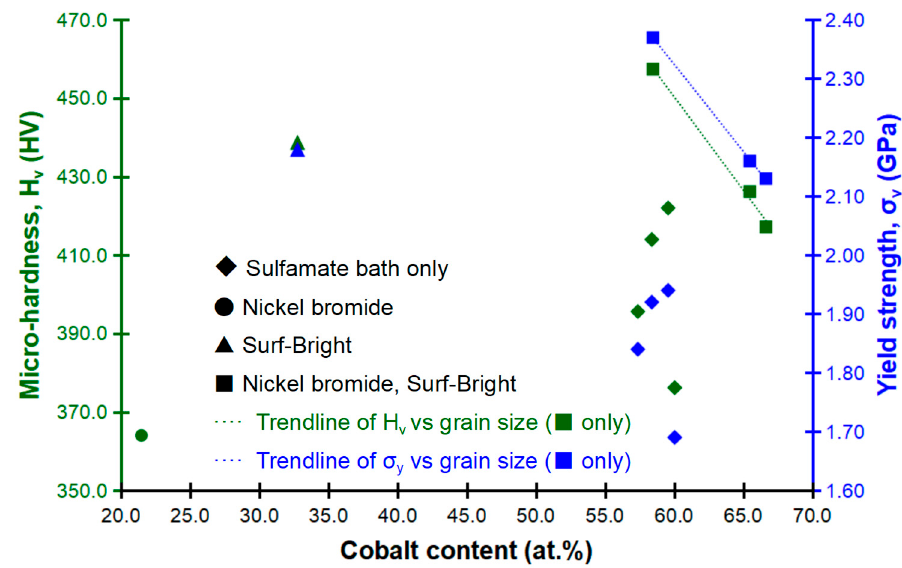
Figure 8. Relationships between the composition, micro-hardness and yield strength.